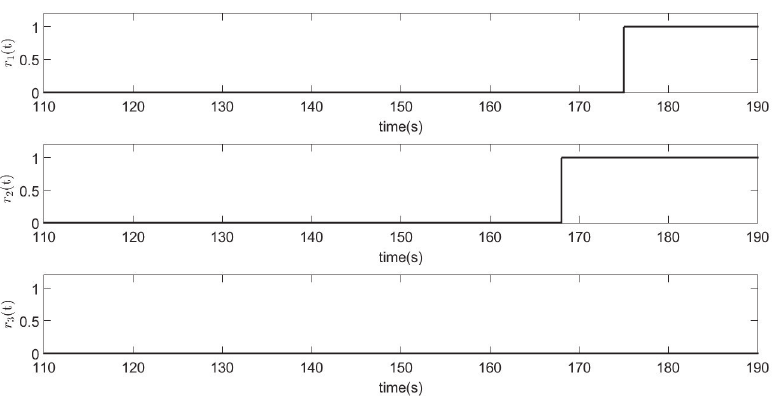
Figure 14. Normalized residual evaluation in case 5 (fault at actuator 2, f a 2